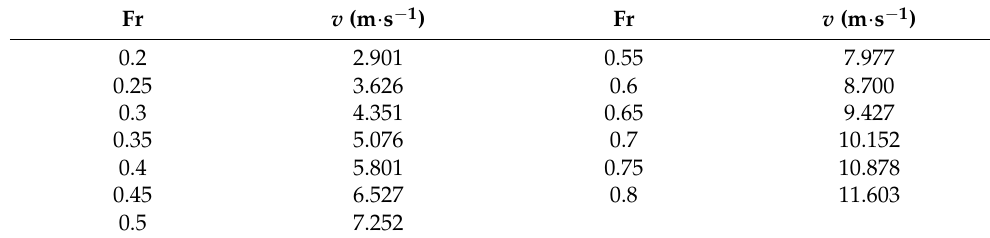
Table 6. Fr corresponding to the ship speed